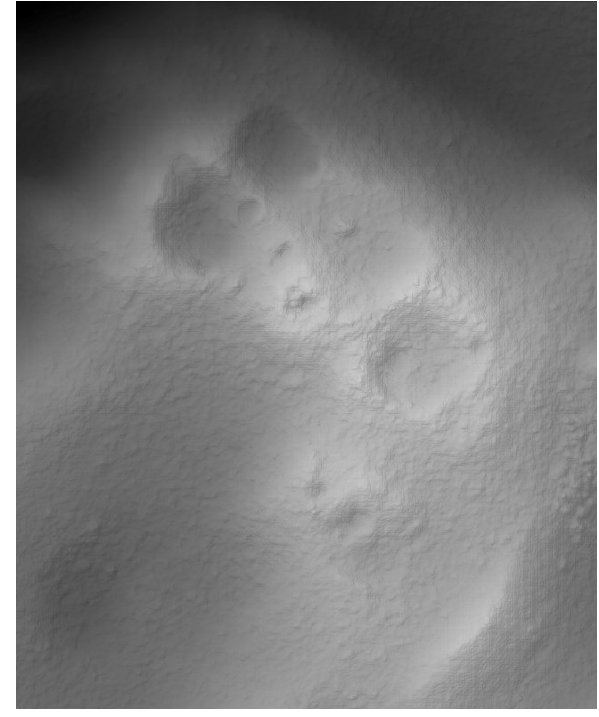
Figure 3. Raster DTM from RPAS imaging